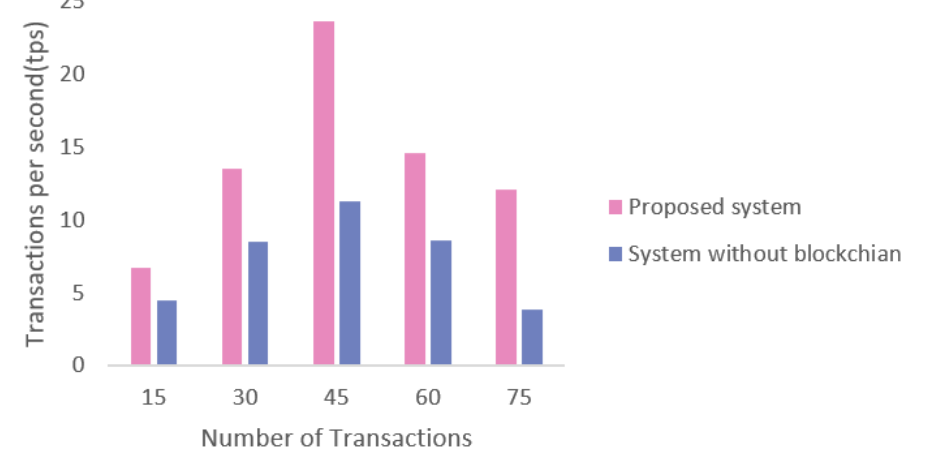
Figure 8. Average throughput comparison between proposed system and system without blockchain. Table 5. Average throughput comparison of proposed system with/without blockchain.